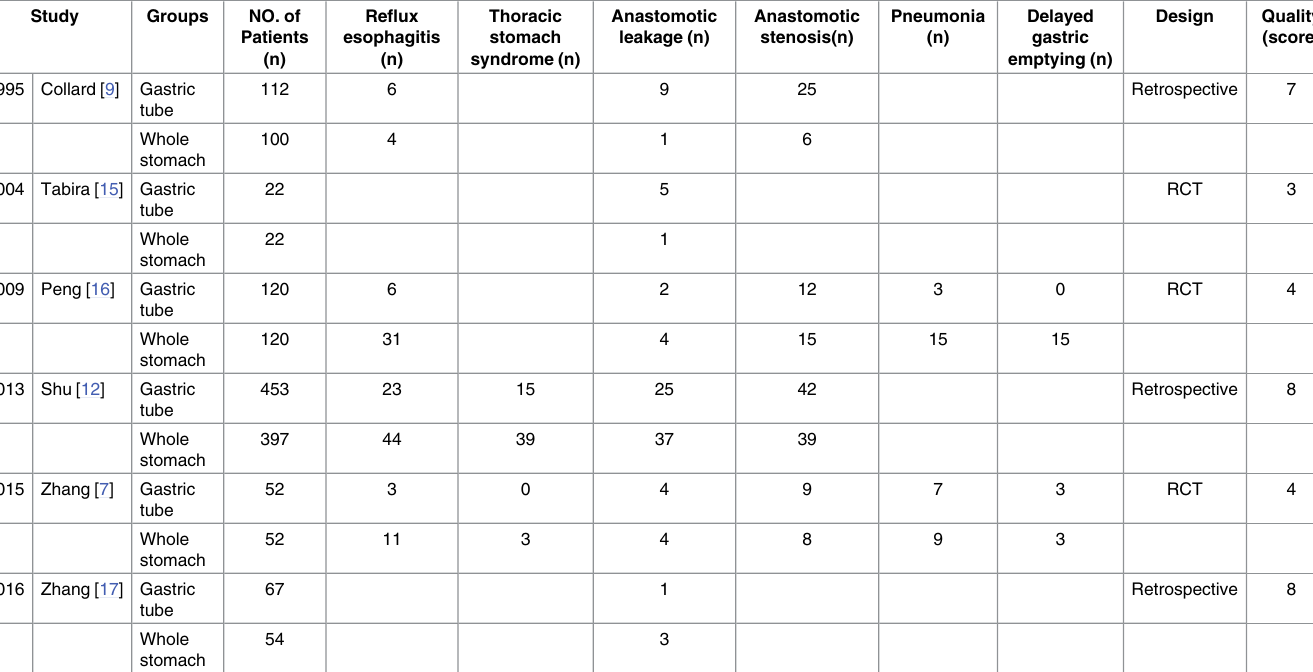
Table 1. Characteristics of the studies included in the